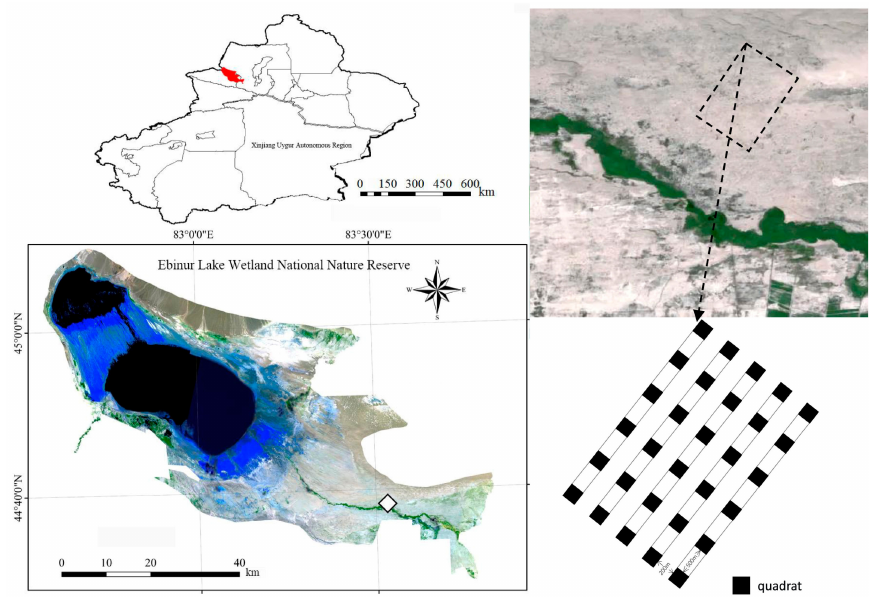
Figure 1. The schematic diagram of sampling and